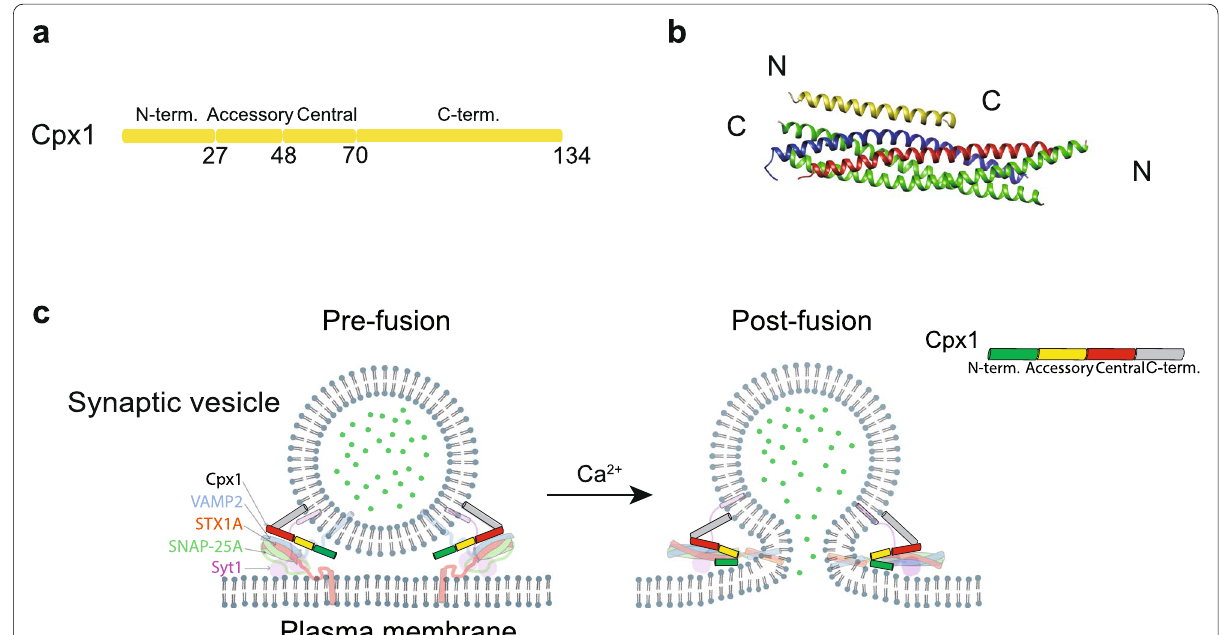
Fig. 5 Cpx1 and its regulatory function. a Domain diagram of Cpx1. Residue numbers are indicated below the diagram. b Crystal structure of the SNARE-Cpx1 complex in Rattus norvegicus (PDB ID: 1KIL) [305]. c Models of how Cpx1 regulates synaptic vesicle fusion. In absence of Ca 2 + , the core fusion machinery is locked to a pre-fusion stage via several interactions from Cpx1: the central α-helical domain interacts with SNARE complex; the accessory α-helical domain involves in a tripartite interface with Syt1 and SNARE complex; C-terminal domain is associated with synaptic vesicle (left). When Ca 2 + influx, Cpx1 inhibition could be released by a conformational change of the tripartite interface upon Ca 2 + binding to Syt1, meanwhile Cpx1 synchronizes synaptic vesicle fusion via its N-terminal domain binds to C-terminus of trans -SNARE complex and plasma membrane